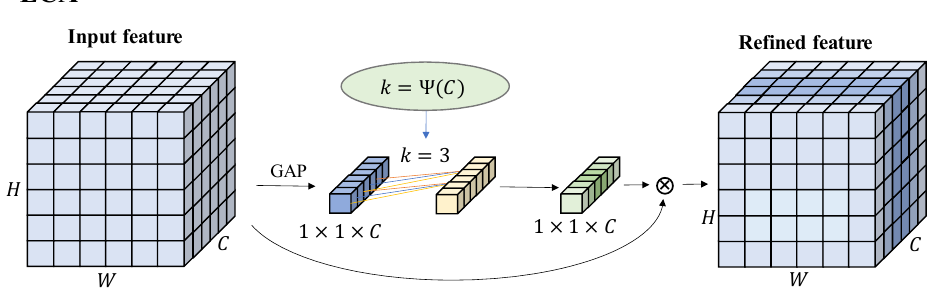
Figure 6. The module structure of ECA.